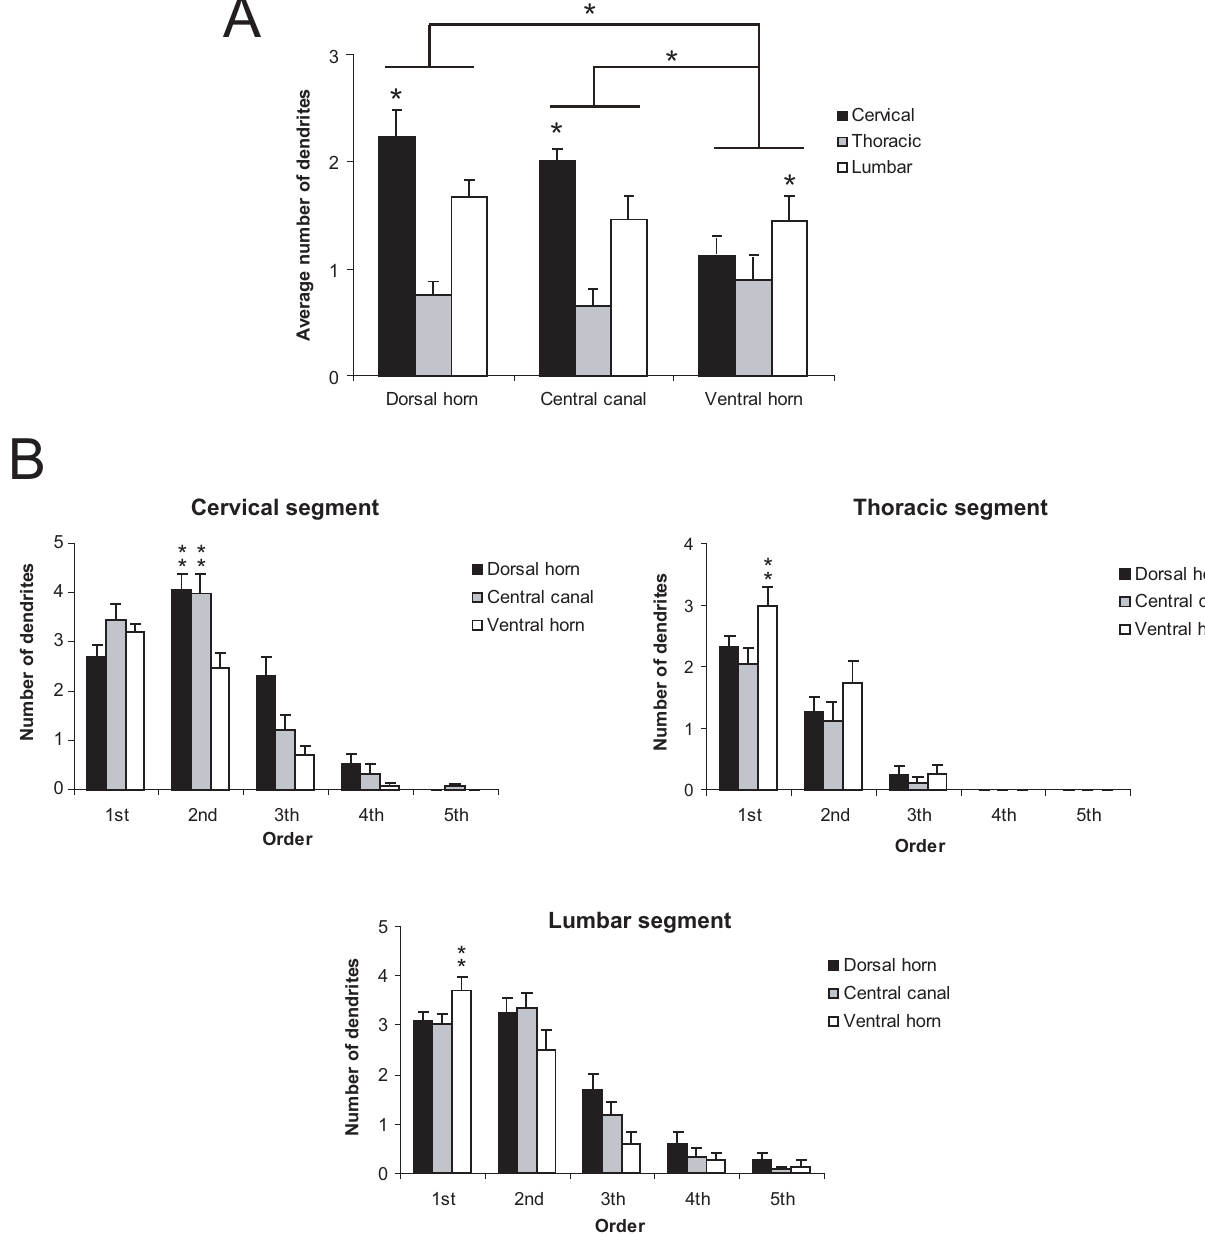
Figure 7. Ramifi cation pattern in the spinal cord. Cells in the cervical enlargement are more ramifi ed (in terms of average number of dendrites) in the dorsal horn and the central canal (A) . Cells of the lumbar enlargement come in second and have the same ramifi cation pattern in its three sub regions (dorsal horn, central canal and ventral horn). Cells in the lumbar and cervical enlargement have more complex dendritic patterns (B) . Asterisks in horizontal bars indicate statistically signifi cant comparisons ( *p < 0.05; **p <